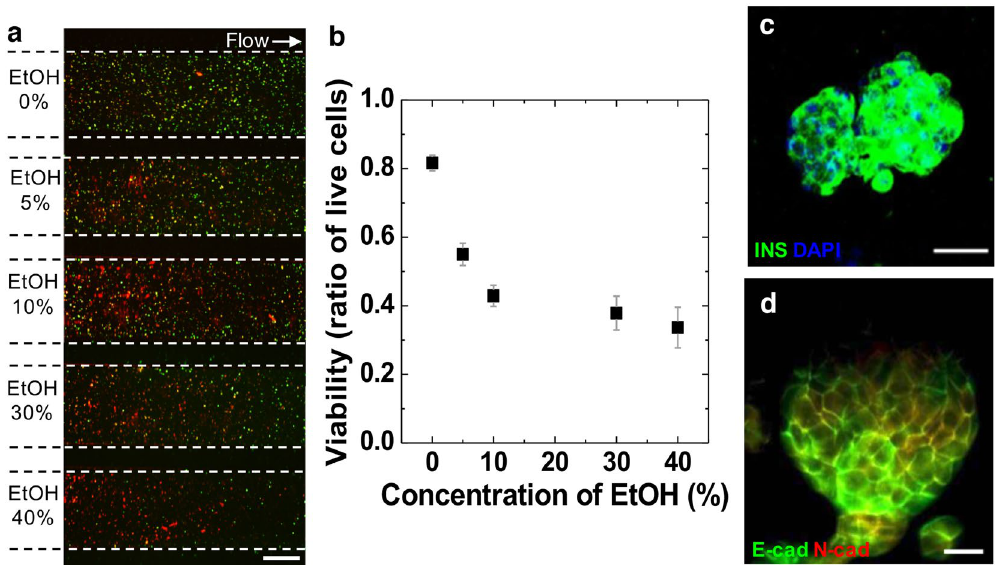
Figure 6. Demonstration of the assessment of the chemical response in the modular hydrogel sheet encapsulating MIN6 cells. ( a , b ) The cell viability was qualitatively or quantitatively examined depending on the various concentrations (0%, 5%, 10%, 30%, and 40%) of ethanol (EtOH) via multiple incubating chambers in the microfluidic assembly platform for 1 h. Scale bar = 500 µ m. ( c , d ) Multicellular clustered MIN6 cells in the modular sheet on day 14 were assessed by flow-based immunostaining for insulin (INS) ( c , green), E-cadherin (E-cad) ( d , green), and N-cadherin (N-cad) ( d , red) in the microfluidic assembly platform. Scale bar = 20 µ